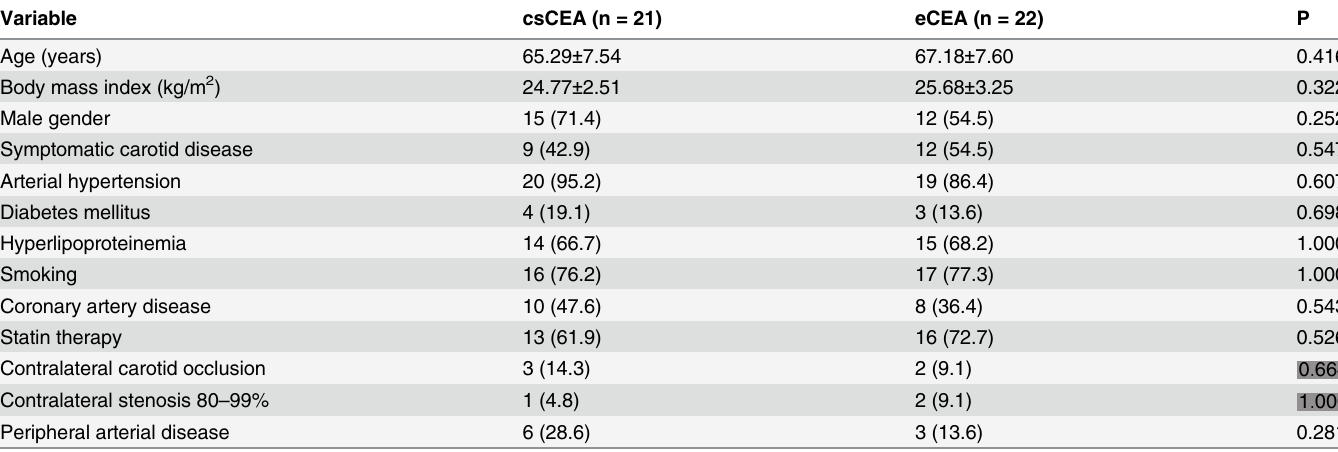
Table 1. Demographics, risk factors and comorbid conditions of CEA